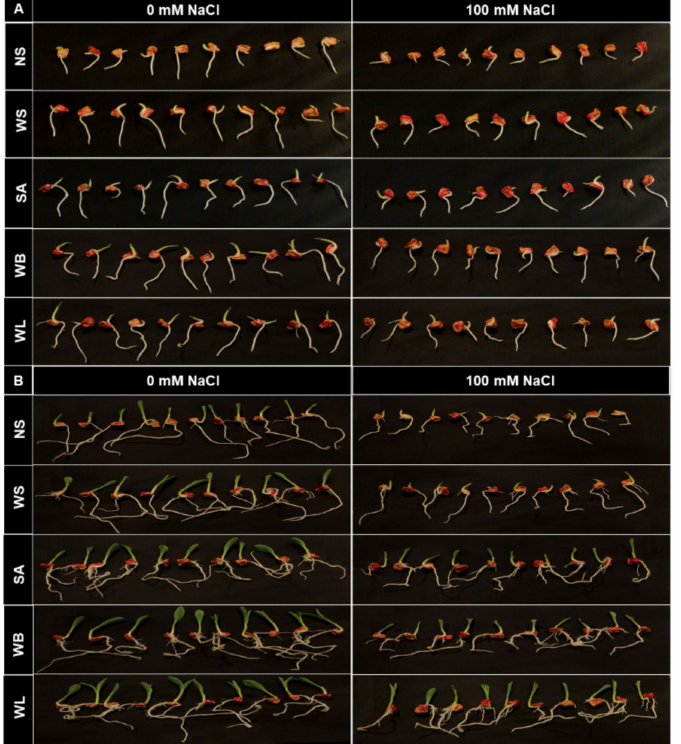
Figure 1. Effect of seed treatment with various agents (NS, non-soaked; WS, water-soaked; SA, salicylic acid (0.5 mM); WB, willow bark extract (2% w / v ); WL, willow leaf extract (2% w / v )) on ( A ) 3-day-old and ( B ) 6-day-old maize ( Zea mays cv. Caramelo) seedlings grown in perlite which was moistened with non-saline (0 mM NaCl) or saline (100 mM NaCl) nutrient solution under growth chamber